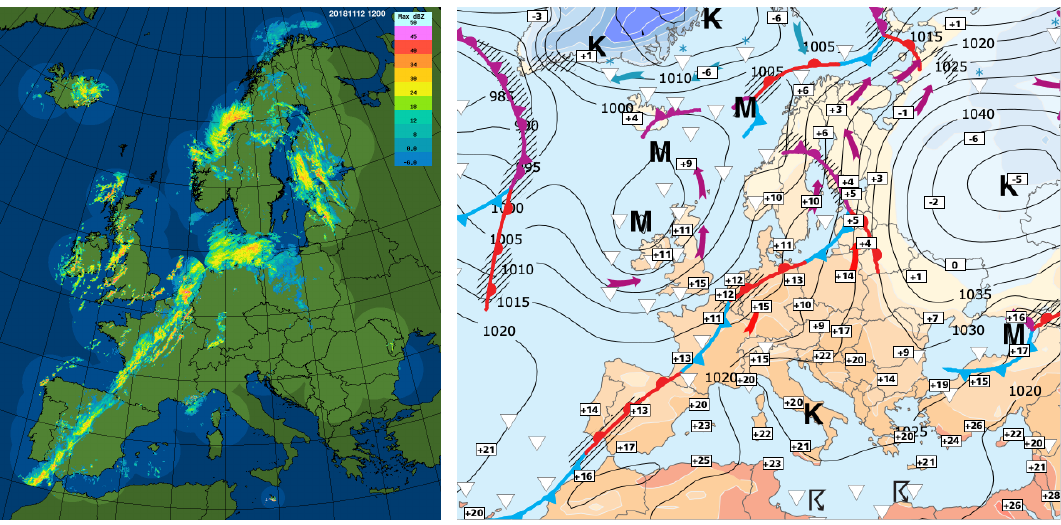
Figure 8. OPERA composite at 12 UTC on 12 November 2018 ( left ) and the corresponding weather map ( right , courtesy of the Finnish Meteorological